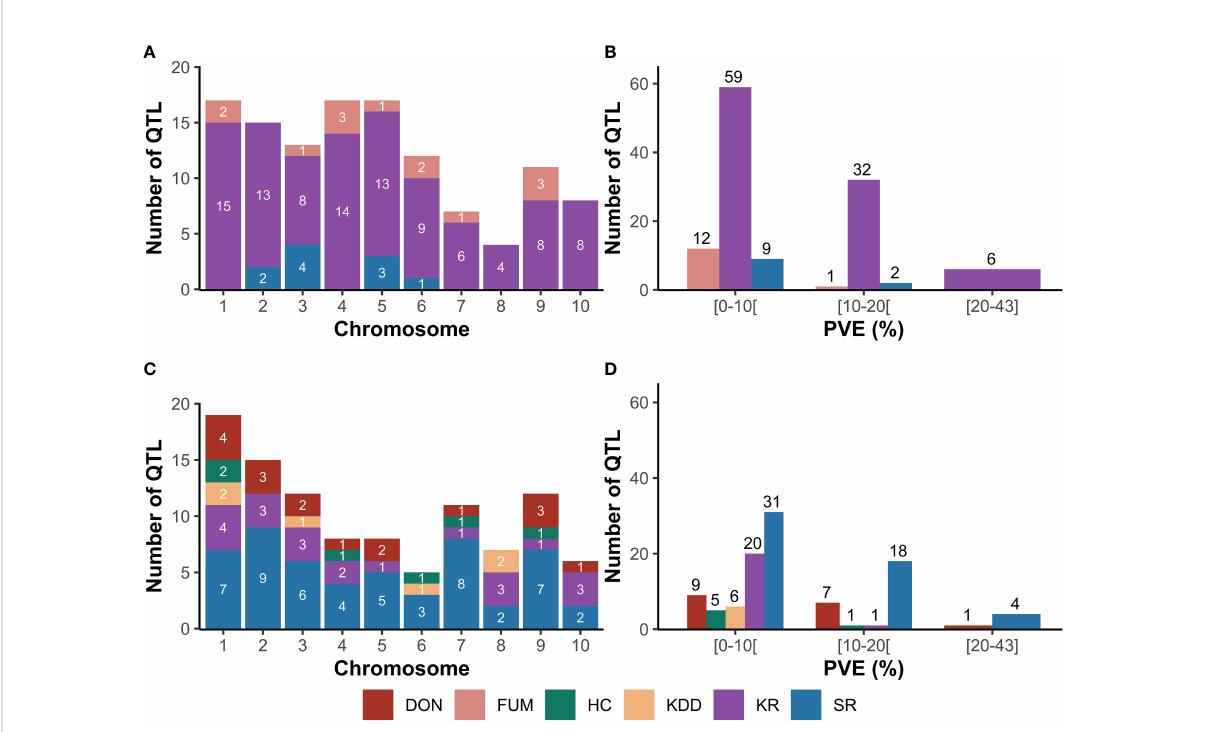
FIGURE 1 Original QTL reported from SNP-based mapping studies for Fusarium ear rot (FER) and Gibberella ear rot (GER). (A) , distribution of QTL for FER across chromosomes; (B) , phenotypic variance explained (PVE) by QTL for FER; (C) , distribution of QTL for GER across chromosomes; (D) , phenotypic variance explained by QTL for GER. DON, deoxynivalenol accumulation; FUM , fumonisin accumulation; HC, husk coverage; KDD, kernel dry-down rate; KR, kernel resistance; SR, silk resistance.